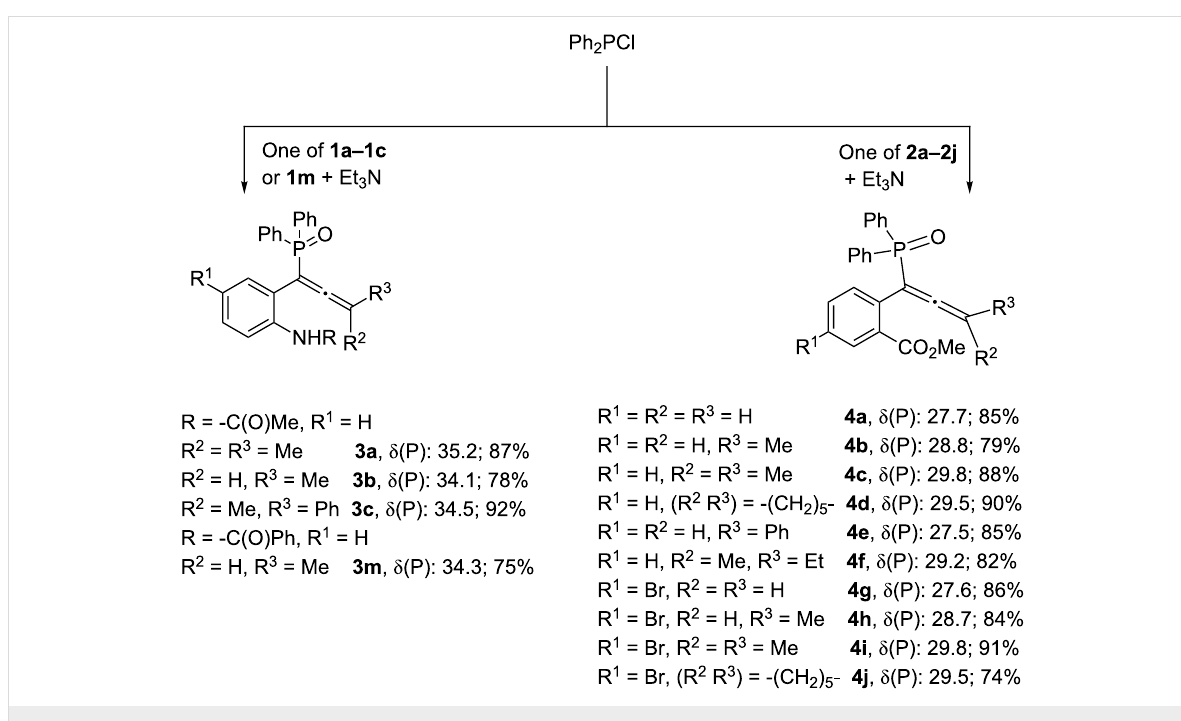
Scheme 2: Synthesis of functionalized allenes 3a–c , 3m and 4a–j